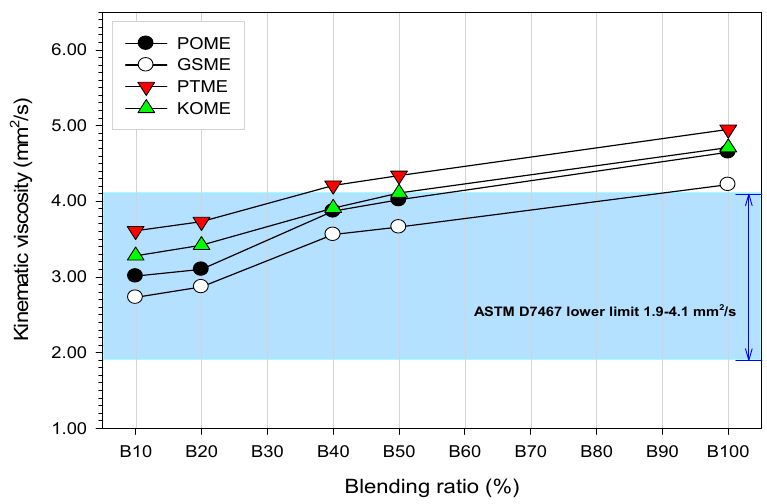
Figure 4. Effects of biodiesel–diesel blends on kinematic viscosity. Figure 4. E ff ects of biodiesel–diesel blends on kinematic viscosity.